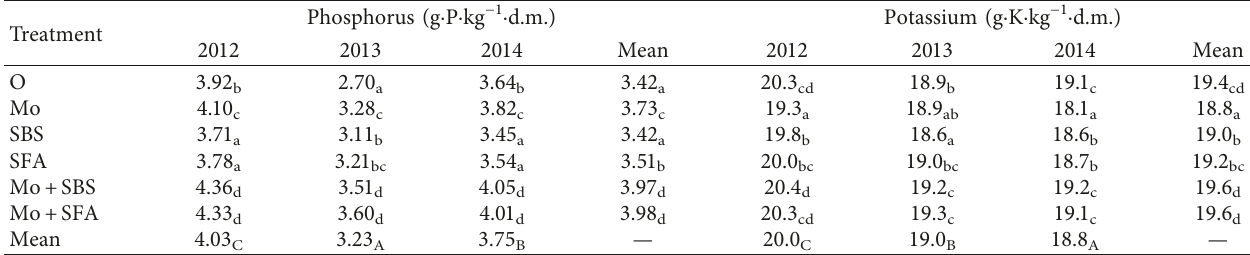
Table 5: The influence of Mo and S application on the phosphorus and potassium content. Treatment